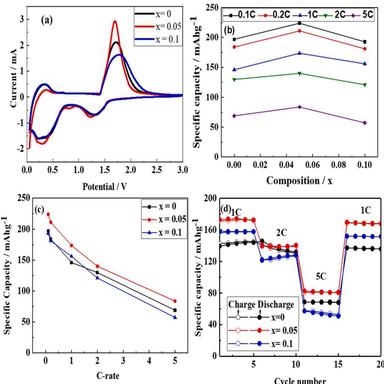
(a) Cyclic voltammetry (CV) curves (b) Rate performance (c) Dependence of specific capacity on C-rate (d) Cycling performance of LZTNO materials at different rates.